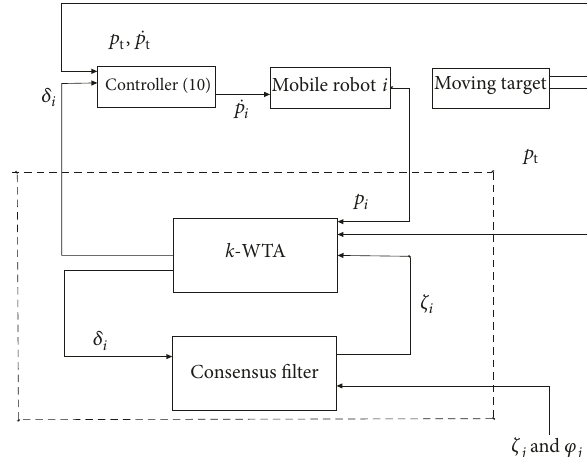
Figure 3: Control block diagram for the 𝑖 th mobile robot in the distributed competitivetarget trackingcontrolvia multiple robotsin the situation of limited communications, where subscript 𝑗 ∈ L (𝑖)